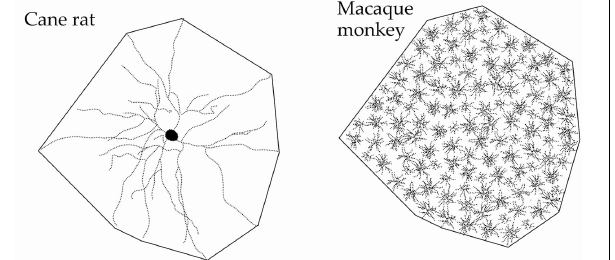
FIGURE 6 | Line drawings, not drawn to scale, illustrating (top) the “average” dendritic tree of layer III pyramidal cells in V1 of the adult cane rat is nearly three times the size of that in the adult macaque monkey. Differences in the size, branching structure, and spine density result in a more than 10-fold difference (middle) in the estimate of the total number of spines, putative excitatory inputs, in the basal dendritic tree of the “average” layer III pyramidal cell between the two species. As V1 in the adult macaque is, on average, more than 40 times the size of V1 in the adult cane rat (bottom), the dendritic trees of cells in the adult cane rat sample a portion of the visuotopic field approximately 120 times larger than do those in the adult monkey (i.e., the dendritic trees of cells in the cane rat are three times larger than those in the macaque and sample from a visuotopic representation 40 times smaller than do those in the macaque). Thus, 120 cells are required in the macaque monkey V1 to achieve the spatial coverage of a single cell in the cane rat. One hundred and twenty cells in the adult macaque V1 have, on average, a sum total of more than 88,000 spines (120 × 743), being more than 110 times the number of spines in an individual cell in the adult cane rat. Although this is a fairly simplistic calculation, and doesn’t take into account features such as branching density (space filling), neuron density, and reciprocal connectivity, it does, we hope, reveal that cortical circuitry in V1 of the cane rat is quantifiably different to that in the macaque